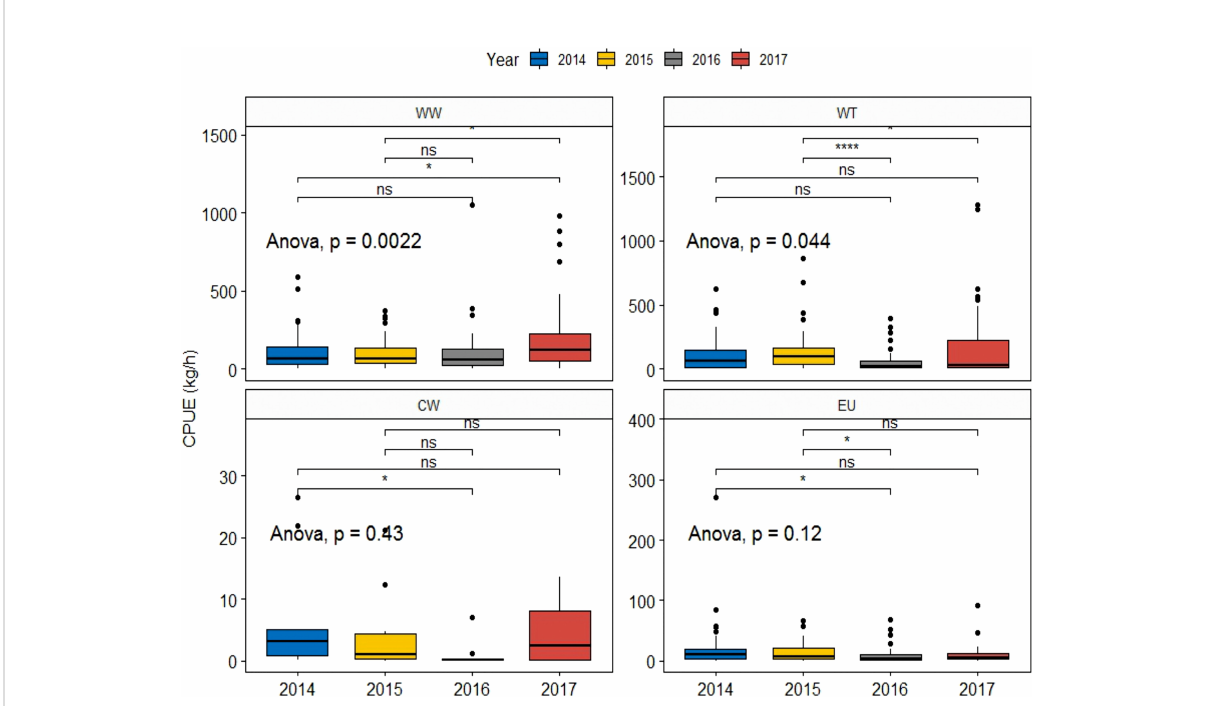
FIGURE 7 CPUE of WW, WT, CT, and EU species in the years before (2014 – 2015) and during (2016 – 2017) the MHW events. All pairs of groups were compared using the Kruskal – Wallis test for one-way ANOVA. * indicates signi fi cance at p<=0.05; **** indicates signi fi cance at p<=0.0001; ns indicates no statistical signi fi